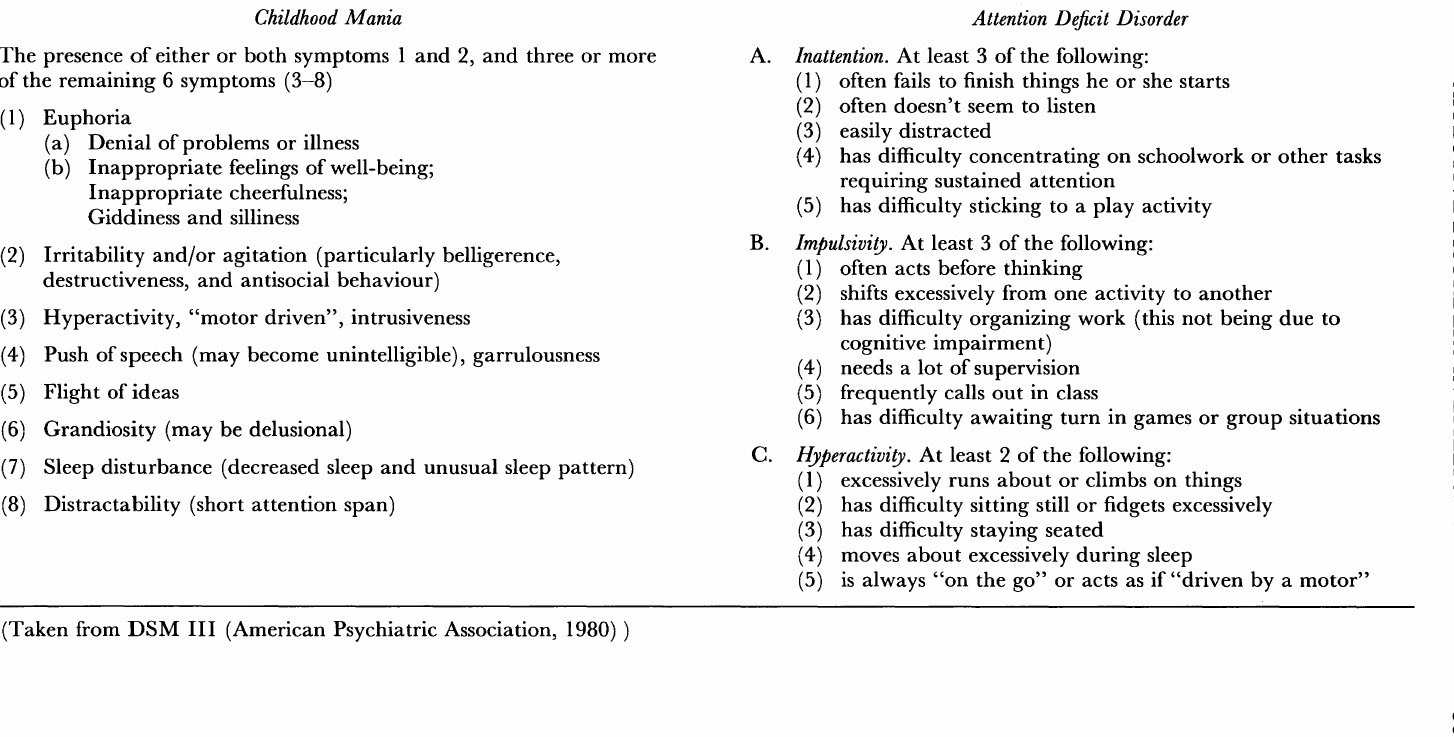
A contrast/comparison if diagnostic criteria for childhood mania and attention dificit disorder Childhood